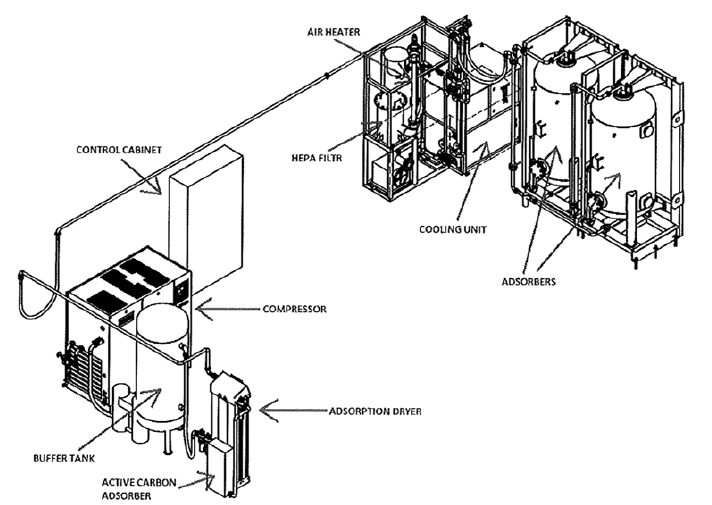
Figure 4. Scheme of the distribution of the elements of the RAS at